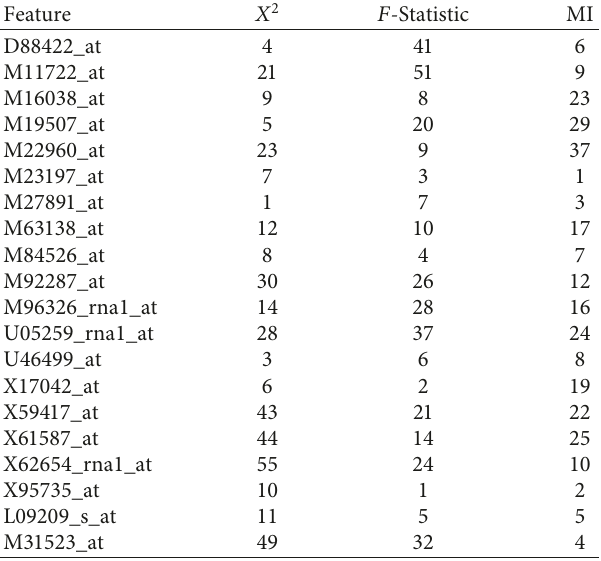
Table 4: Feature rank table (RT) for the leukemia dataset. Eval- uation scores are converted to ranks, with 1 being the highest rank.